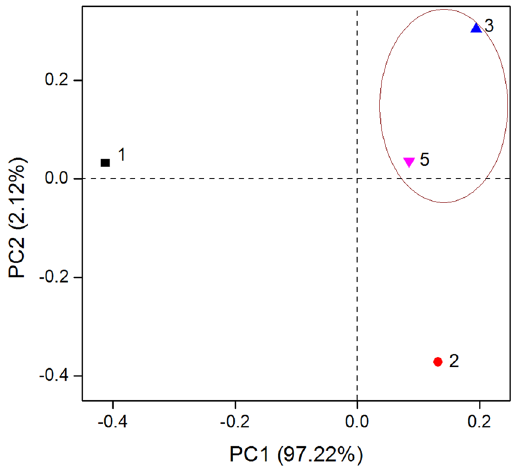
Figure 2. PCA analysis of DNRA communities in the Yellow River Estuary. The circle indicates that the communities in the two sites share higher similarities. Percentages represent the amount variance explained by each